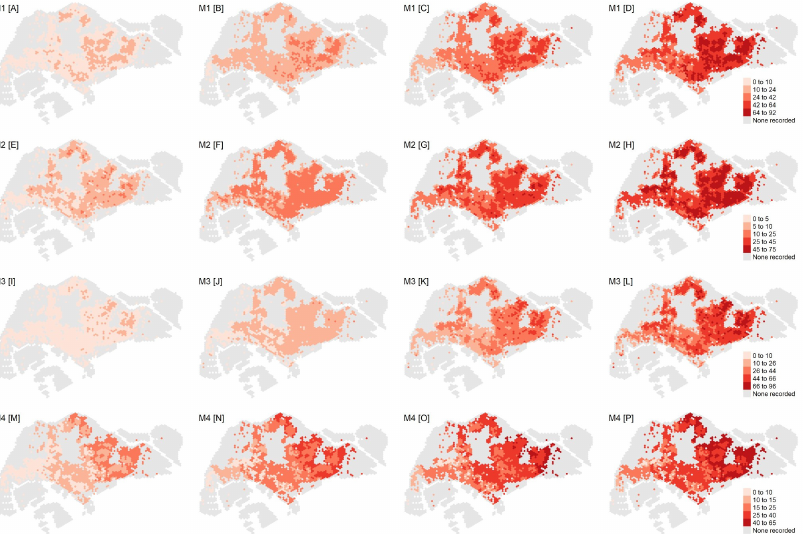
Figure 2. Top row from left to right: return levels for M1 associated with a (A) 5-year, (B) 10-year, (C) 20-year, and (D) 30-year return period. Second row from left to right: return levels for M2 asso- ciated with a (E) 5-year, (F) 10-year, (G) 20-year, and (H) 30-year return period. Third row from left to right: return levels for M3 associated with a (I) 5-year, (J) 10-year, (K) 20-year, and (L) 30-year return period. Fourth row from left to right: return levels for M4 associated with a (M) 5-year, (N) 10-year, (O) 20-year, and (P) 30-year return period. The legend for the return level of each row is shown on the right.